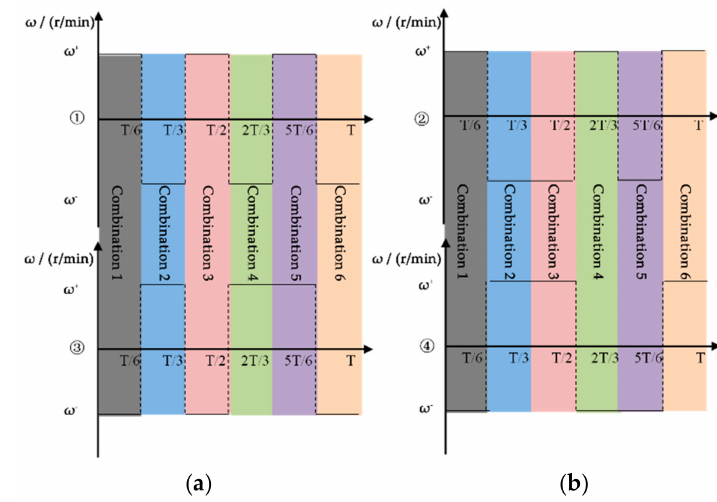
Figure 3. Diagrammatic sketch of the switch combination of the rotating shaft: ω + and ω - mean the forward rotation and backward rotation. ( a ) theoretical random rotation; ( b ) practical random